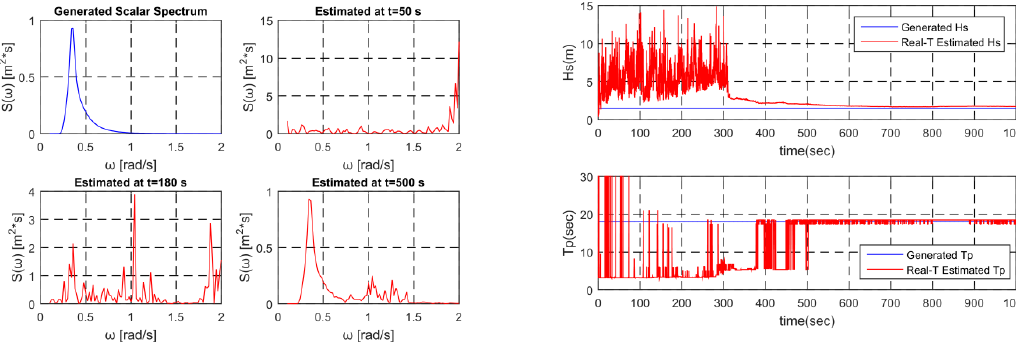
Appl. Sci. 2019 , 9 , x FOR PEER REVIEW Figure 27. Generated and estimated spectrum / Evolution of parameters (Sea sate 6, Hs = 1.5 m, Tp = 18 s). Figure 27. Generated and estimated spectrum/Evolution of parameters (Sea sate 6, Hs = 1.5 m, Tp = 18 s).